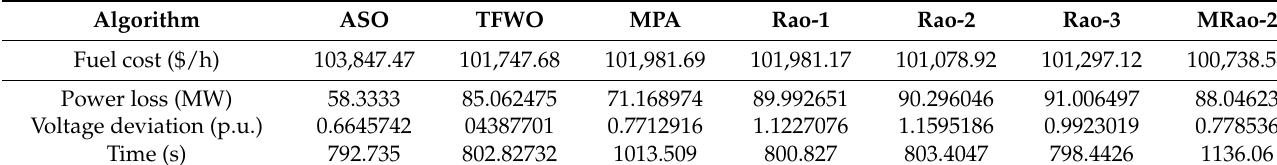
Table 12. Results of the proposed MRao-2 algorithm and other algorithms for case 5.